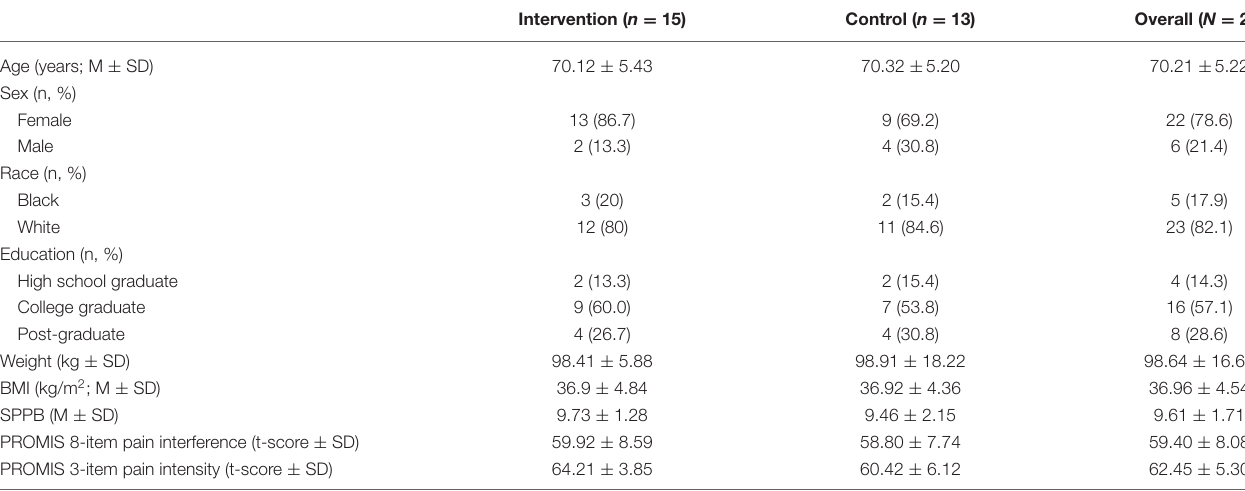
TABLE 2 | Participant characteristics at baseline within the pilot phase.